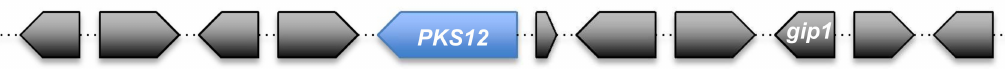
Figure 3. Biosynthetic gene cluster for aurofusarin in F. graminearum . Based on Hoffmeister and Keller